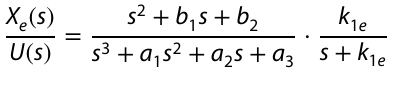
Table 1 Nomenclature for the PK/PD model [9, 14]